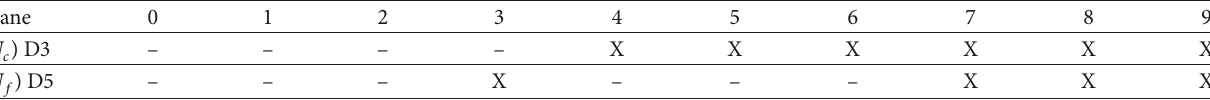
Table 2: Fundamental sector introduced in the background of 𝑁 푐 D 3